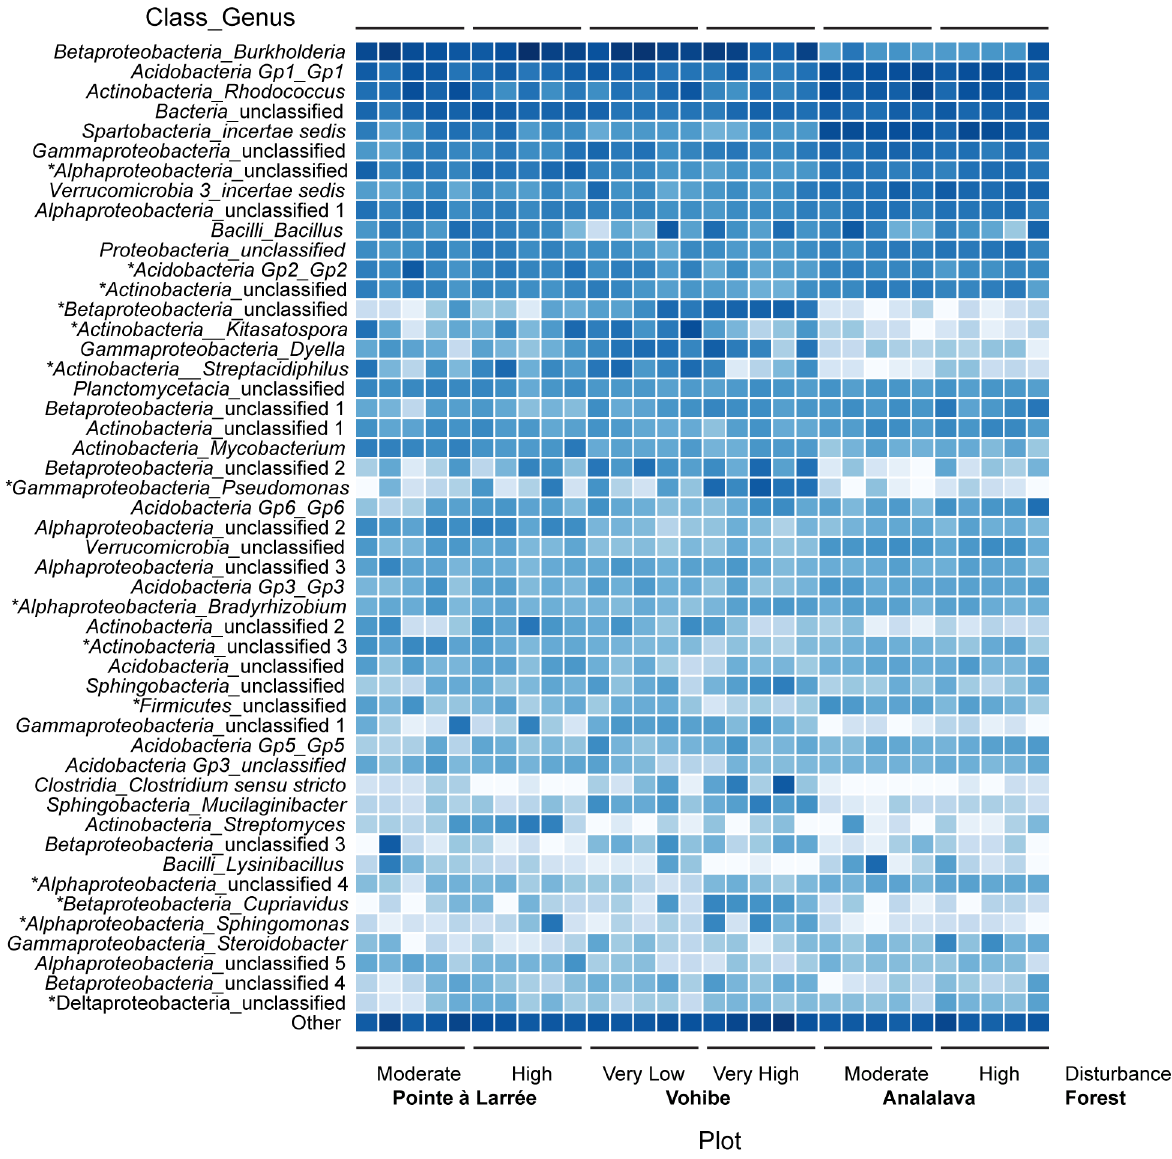
Figure 2. Log transformed abundance of dominant bacterial genera by sample. Sequences in 3% OTUs were classified and grouped at the genus level. Taxa representing , 0.3% of the total sequences were grouped as Other. Darker color indicates higher relative abundance. Asterisks indicate taxa with significant shifts in abundance between disturbance levels at Vohibe (see Table 5).